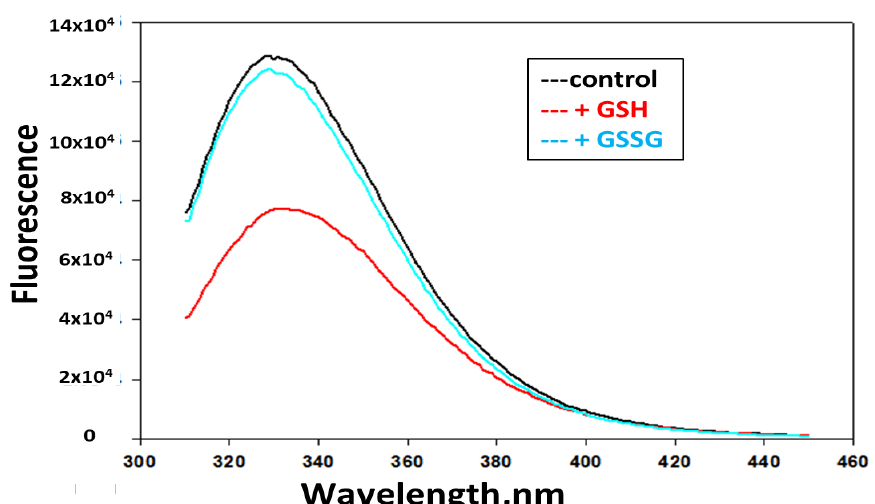
Figure 3. Effect of glutathione (GSH) and oxidized GSH (GSSG) on trptophan fluorescence emission of Prdx6 at pH 7. There is decreased fluorescence of Prdx6 in the presence of GSH while the presence of GSSG had no effect.